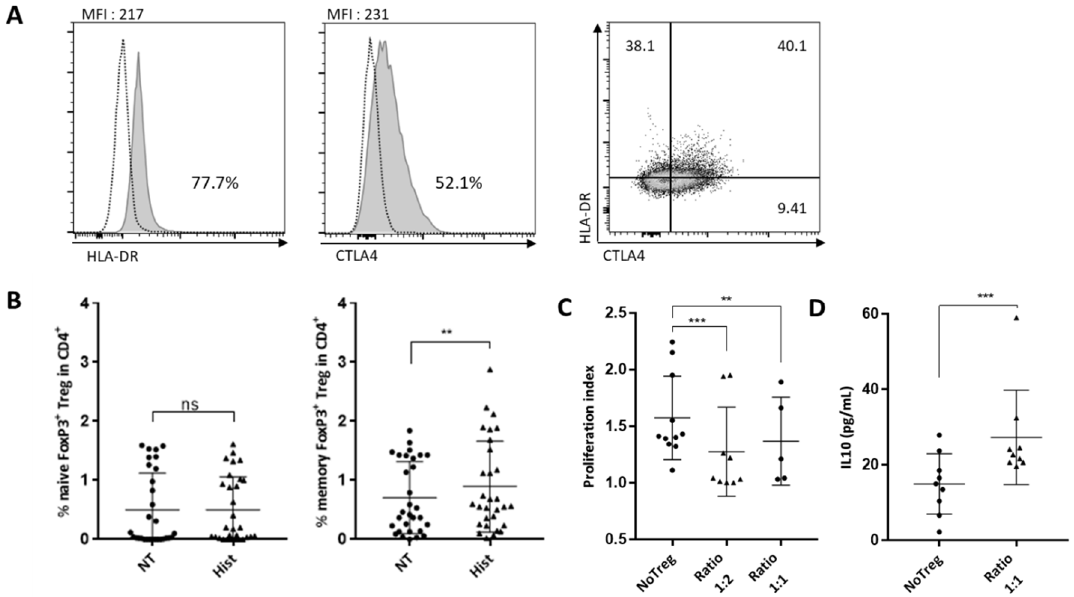
Figure 3. Phenotype and function of Treg induced by histone-activated endothelial cells. ( A ) Phe- notype of Tregs induced in cocultures with HMEC pre-treated with histones were assessed using anti-CD45-RA, -HLA-DR and -CTLA-4 antibodies. Gating was performed using Fluorescence Minus One (FMO) control. ( B ) Naïve Tregs are CD45RA + whereas CD45RA − are memory Tregs. Results are expressed as the percentage of cells in CD4 + cells. Memory Treg expansion was significantly increased in co-culture with histone-pretreated endothelial cells (Wilcoxon test, ** p = 0.0037, n = 30). ( C ) The suppressive ability of Tregs sorted from co-cultures with HMECs pre-treated with histones was assessed. Proliferation of autologous CD4 + -T cells were measured by dilution of Cell Trace Violet staining. Analysis was made with the Proliferation Tool on FlowJo X. The proliferation index from three different conditions is reported here: Tresp alone, ratio 1 Treg:2 Tresp, and ratio 1 Treg:1 Tresp. Proliferation Index is the total number of cell divisions divided by the number of cells that went into division. Adapted with permission from FlowJo Tutorial, Tech Notes and Web Site Copyright © FlowJo LLC., 1997–2019 [18]. Tregs significantly reduced CD4 + -T cells proliferation at the ratio 1:2 (Paired t -test, *** p = 0.0007) and at the ratio 1:1 (Paired t -test, ** p = 0.0052, (n = 5–9)). ( D ) Levels of IL-10 were measured by ELISA at the end of the suppression assay. IL-10 concentration was increased in the presence of Tregs (Mann–Whitney test, *** p = 0.001, n =